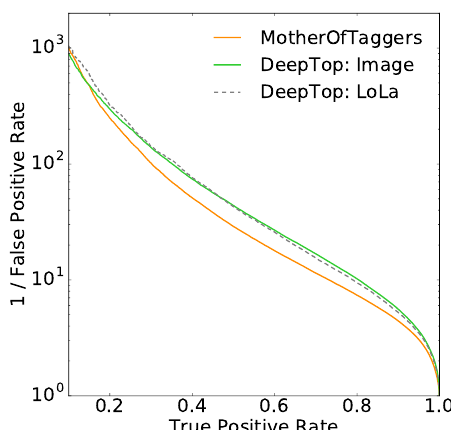
Figure 3: ROC curve for the new D EEP T OP L O L A tagger, compared to the QCD-inspired M OTHER O F T AGGERS and the image-based D EEP T OP tagger [ 31 ] . In all cases we